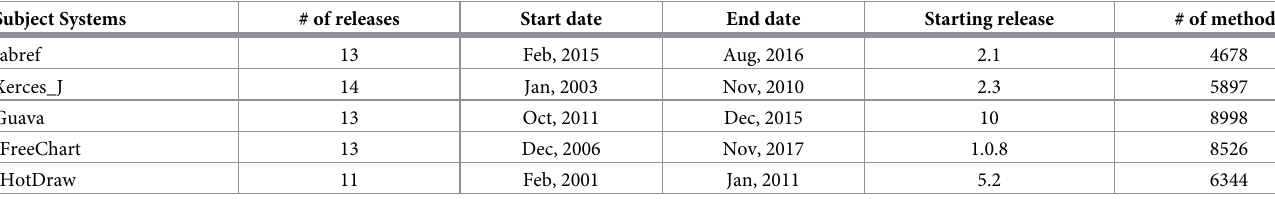
Table 1. Statistics of software